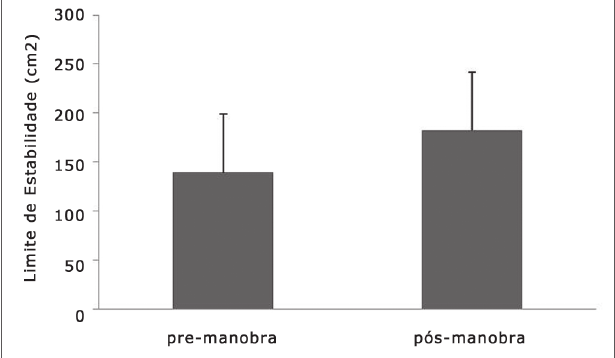
Figura 1. Área do Limite de Estabilidade (LE) antes e após a manobra de Epley. *Wilcoxon Signed Ranks Test